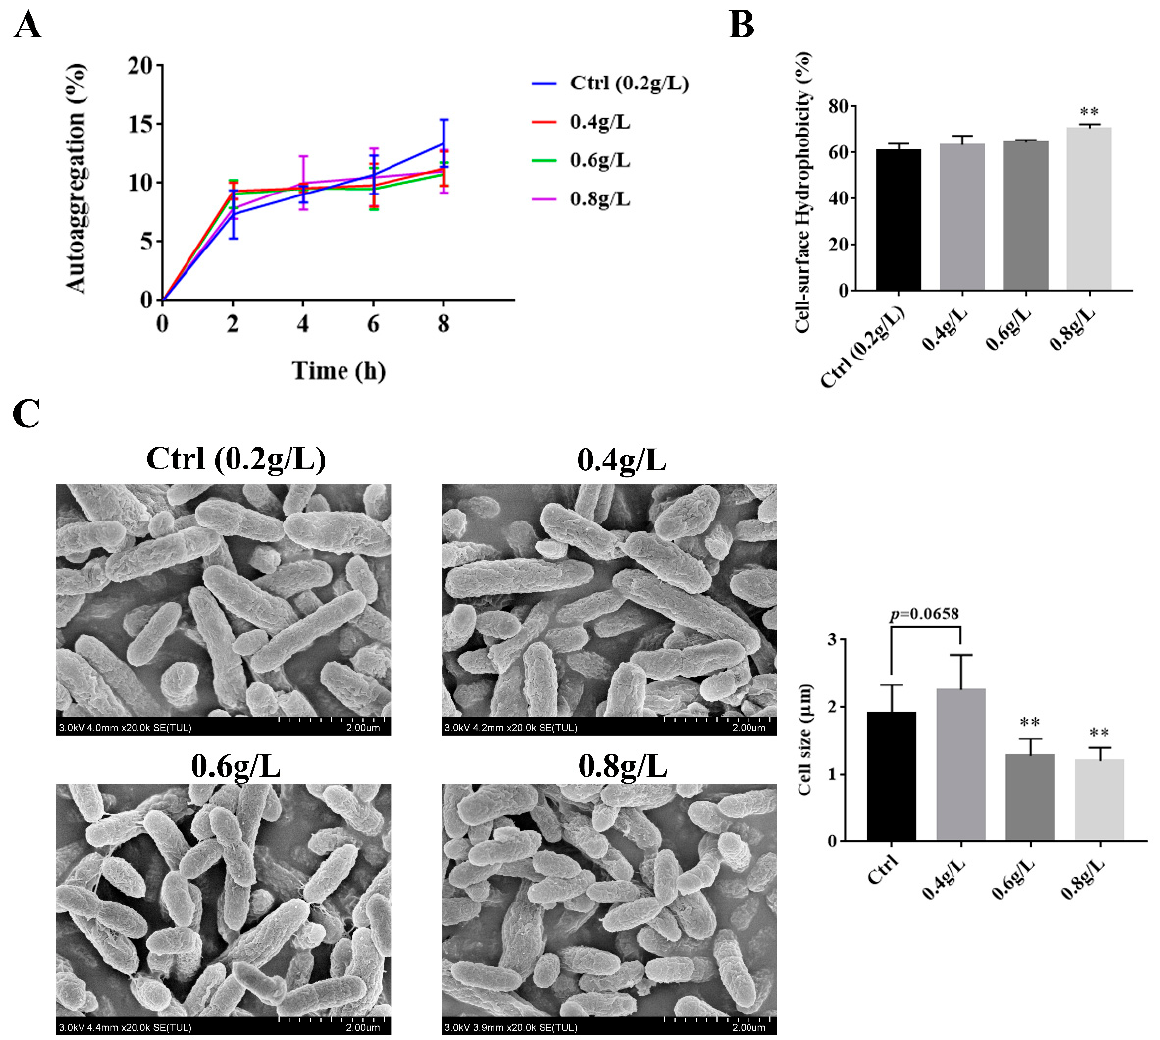
Figure 2. Effects of 0.2, 0.4, 0.6, and 0.8 g/L of tryptophan on auto-aggregation, hydrophobicity, and adhesion of A. muciniphila BAA-835 T . ( A ) The auto-aggregation (%) of A. muciniphila BAA-835 T every 2 h. ( B ) The cell-surface hydrophobicity (%) of A. muciniphila BAA-835 T . ( C ) Scanning electron microscope (SEM) of A. muciniphila BAA-835 T . One-way ANOVA with a post hoc Dunnett test was used to determine statistical differences, compared with the Ctrl group. ** p < 0.01. 3.3. The Effect of Tryptophan on the Adhesion Ability of A. muciniphila to HT-29 Cells